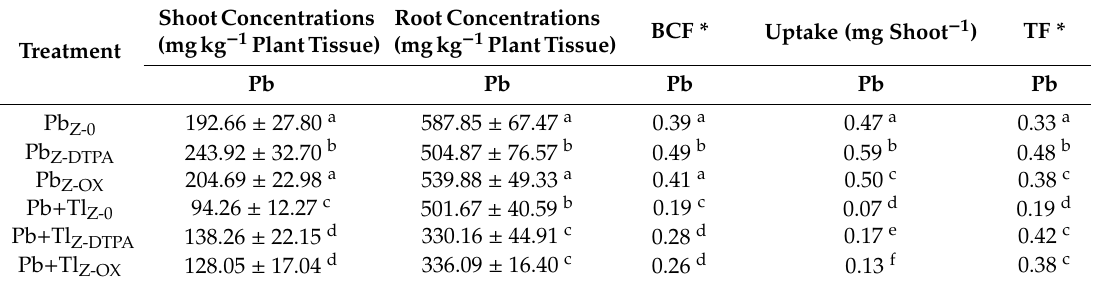
Table 2. Enrichment and transfer coe ffi cient of Pb in maize by chelator-enhanced remediation in glasshouse